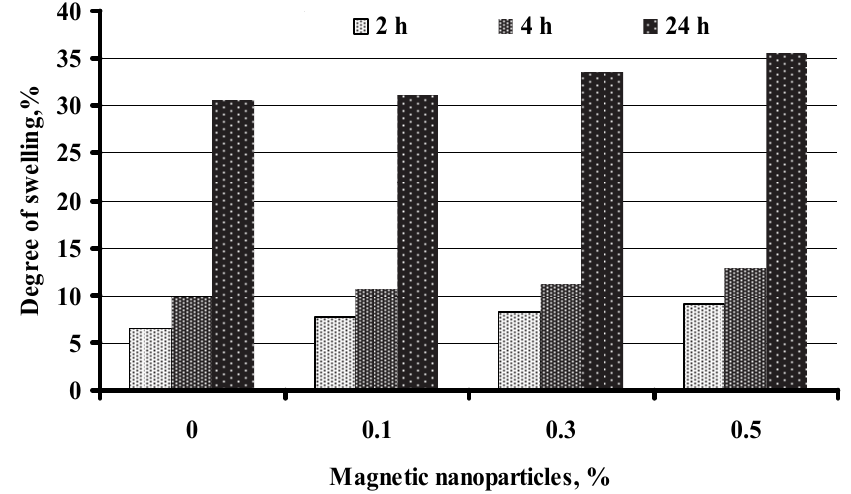
Figure 8: Changes of degree of swelling (weight) in dependence on the amount of magnetic nanoparticles.